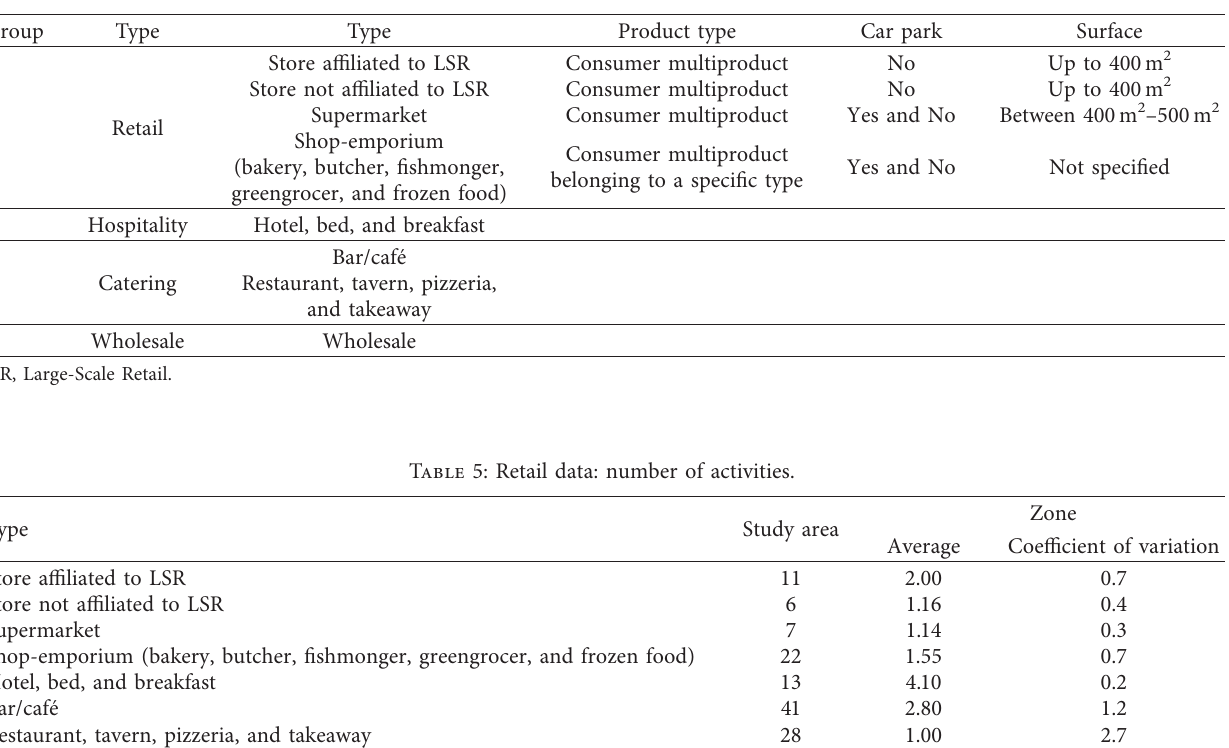
Table 4: Classification of commercial establishments.